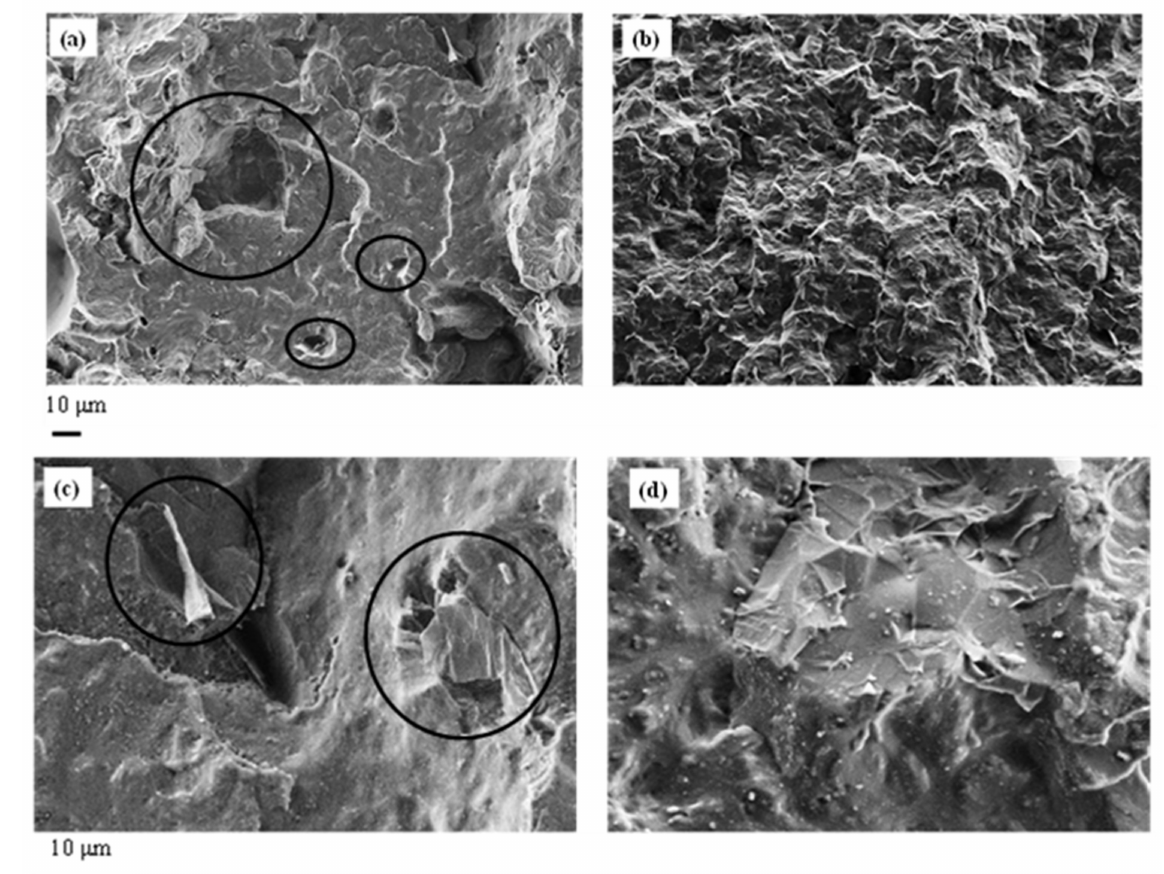
Figure 7. FE-SEM micrographs at different magnifications of: ( a , c ) PCL/G1 and ( b , d )